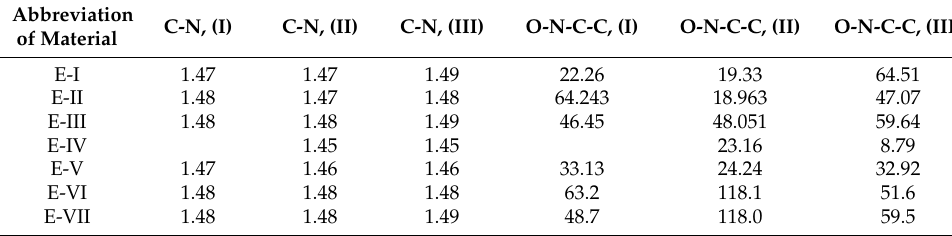
Table 1. Selected bond length (A) and dihedral angles (degrees) of the molecules under investigation.